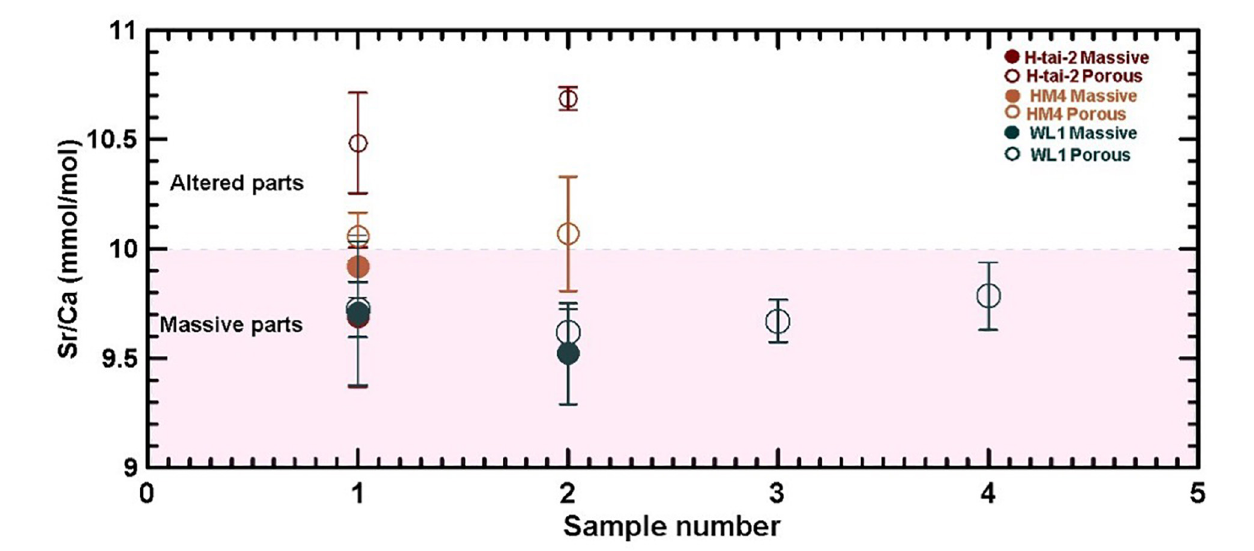
FIGURE 4 | Sr/Ca results from micro-mill based sampling in coral samples affected by diagenesis (H-Tai-2 and HM4). The sampling targeted two different skeletal phases – massive coral areas vs. porous parts. Light pink band indicates measurements below the threshold value of 10 mmol/mol. Data from a sample considered well-preserved based on microscope observations (WL1) is provided for comparison, laying below the defined threshold value.